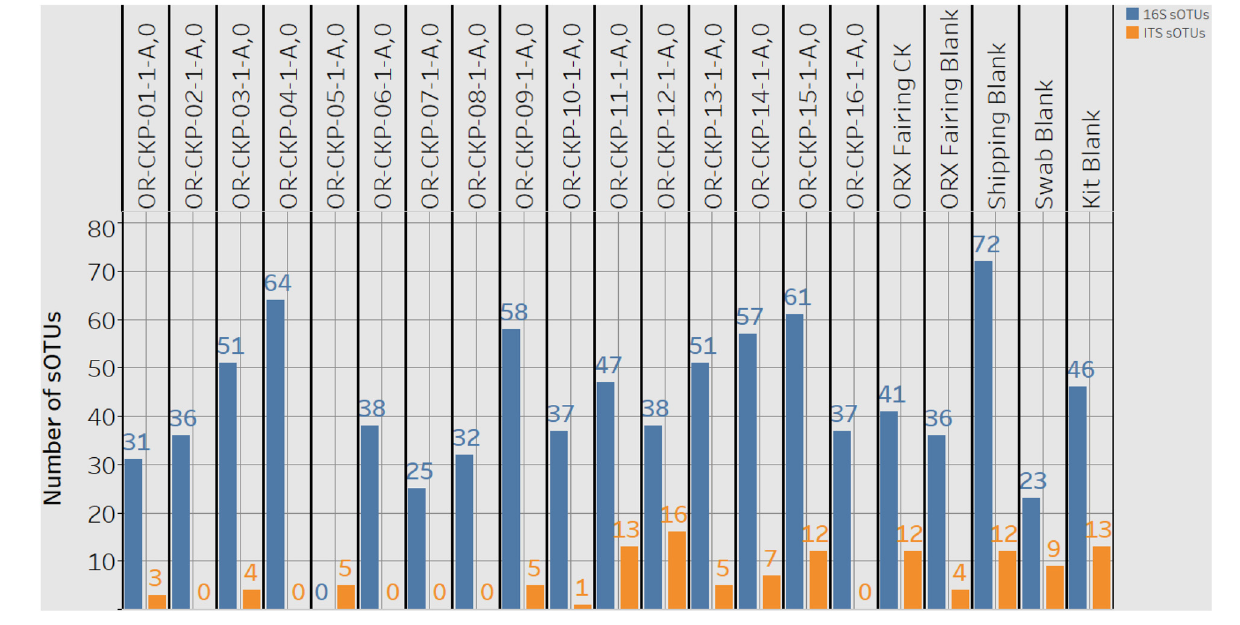
Sample 12 had the largest number of fungal OTUs (16) ( Figure 4 ) and the largest number of ITS sequences ( Figure 4 ) (192,263). This sample was collected in the SSB while the launch